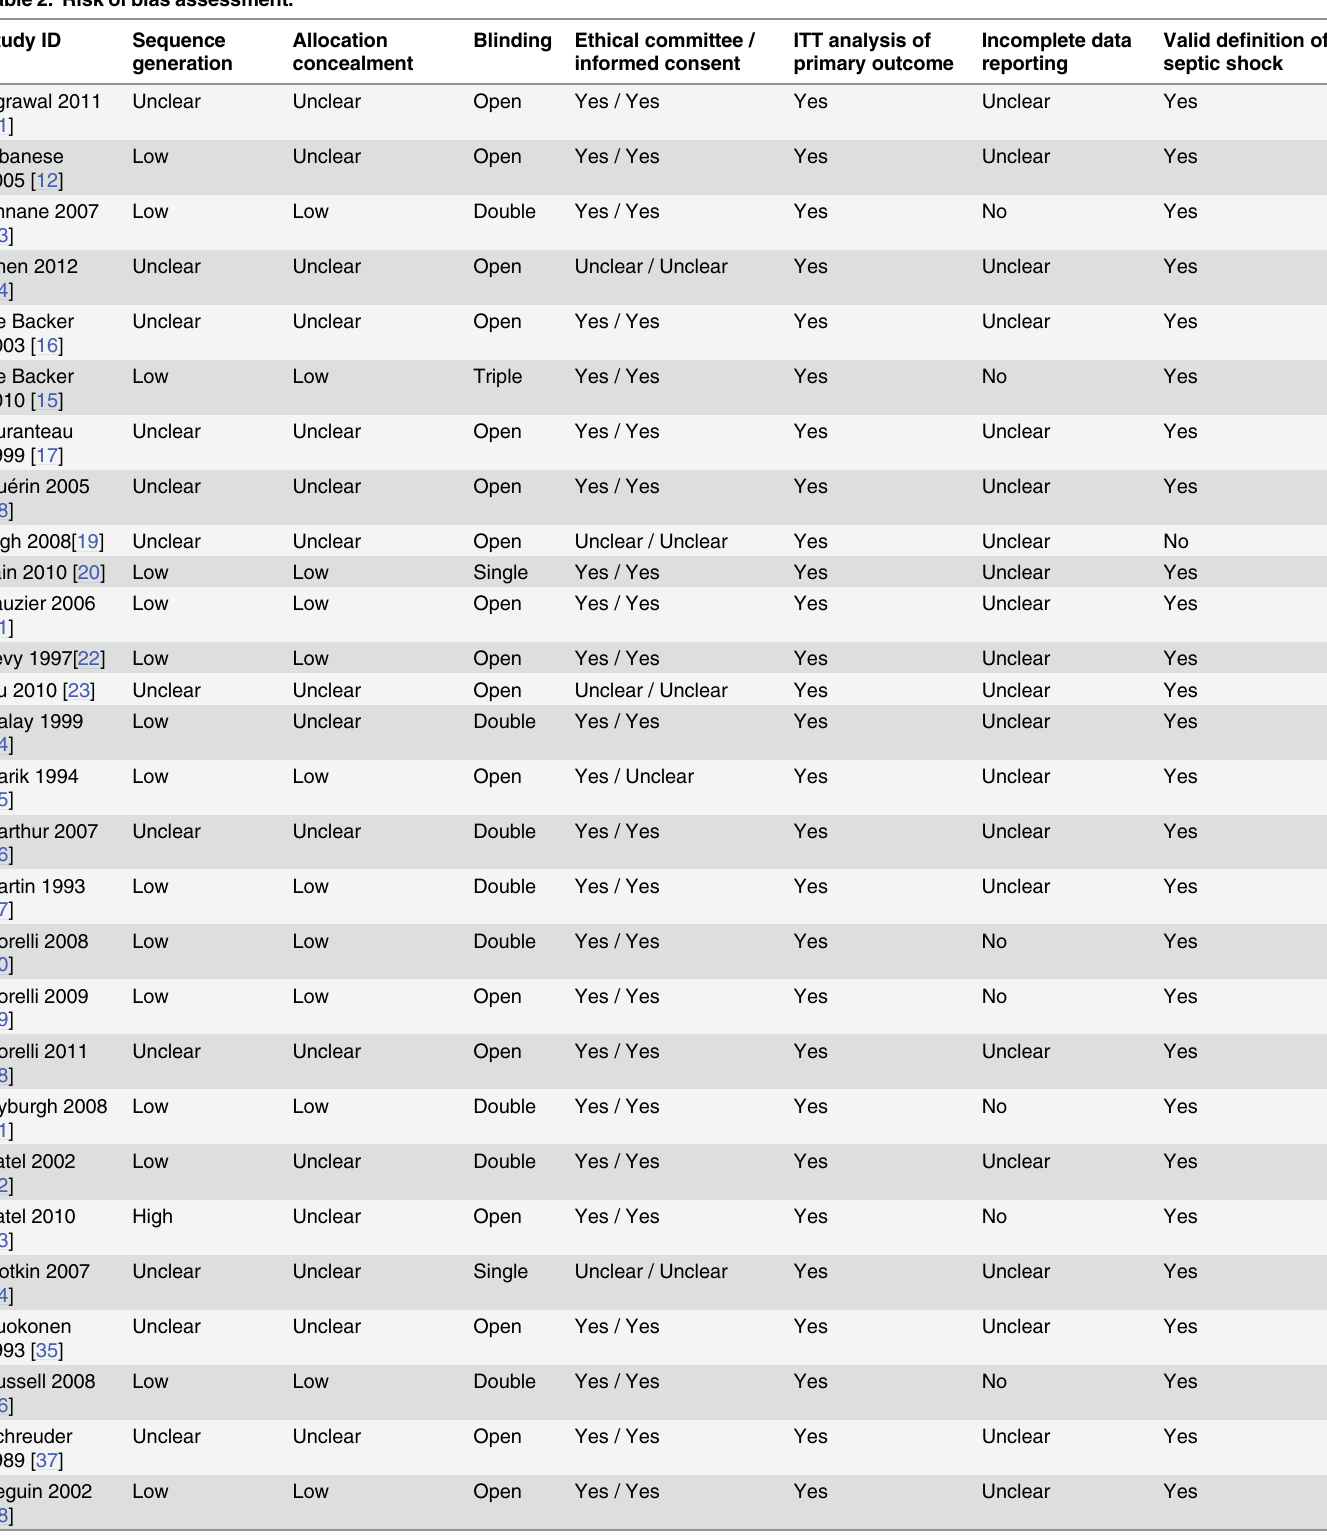
Table 2. Risk of bias